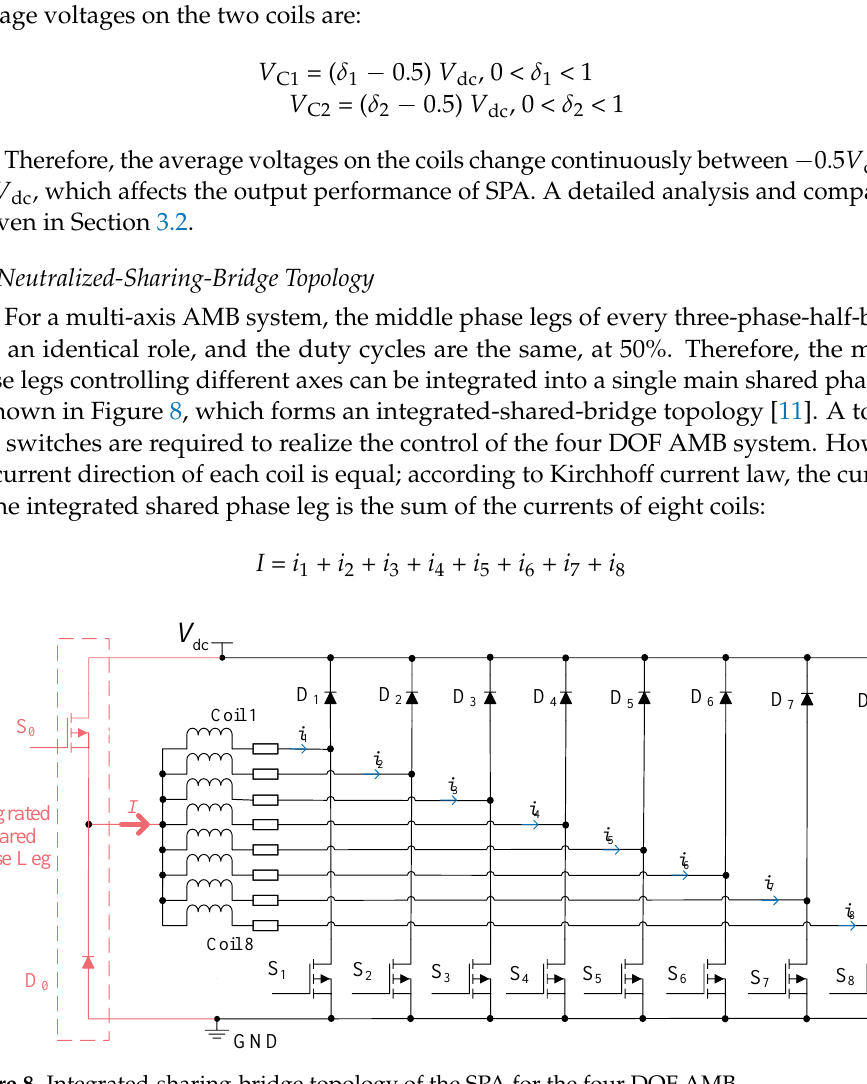
Figure 8. Integrated-sharing-bridge topology of the SPA for the four DOF AMB .